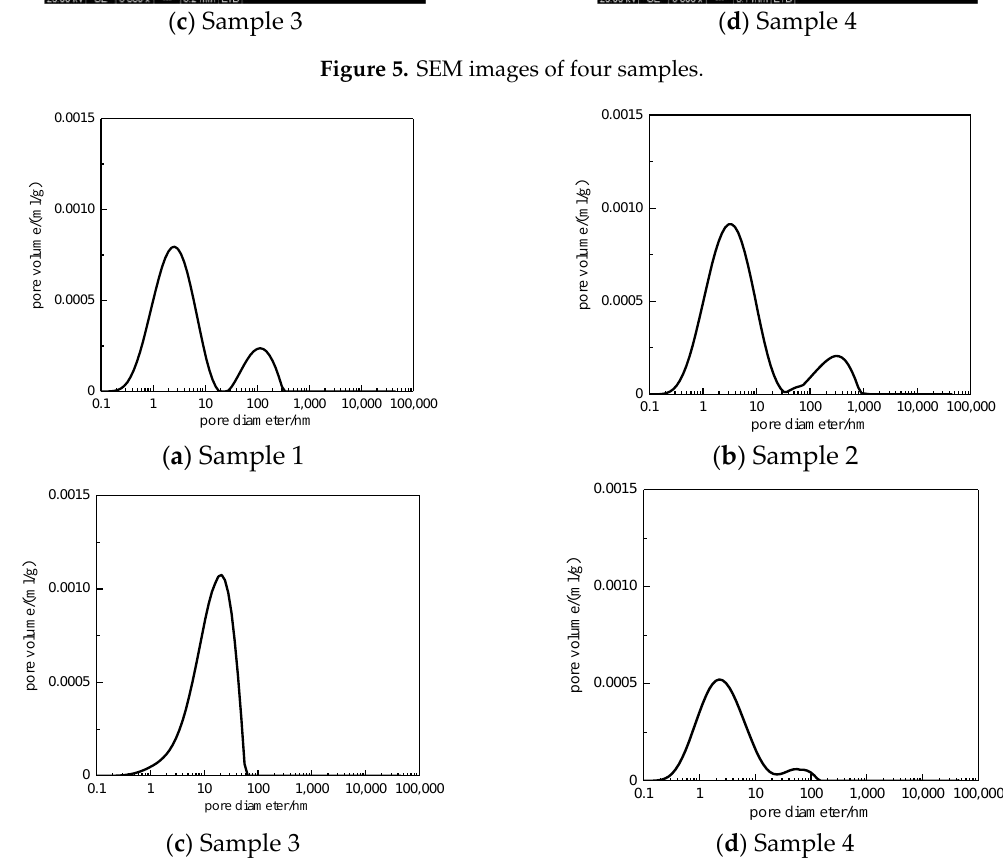
Figure 5. SEM images of four samples.